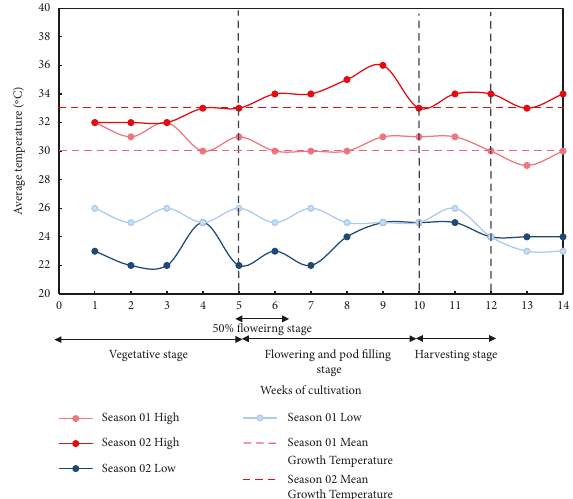
Figure 1: Weekly minimum and maximum temperature during two seasons that three cowpea varieties were cultivated in Anu- radhapura, Sri